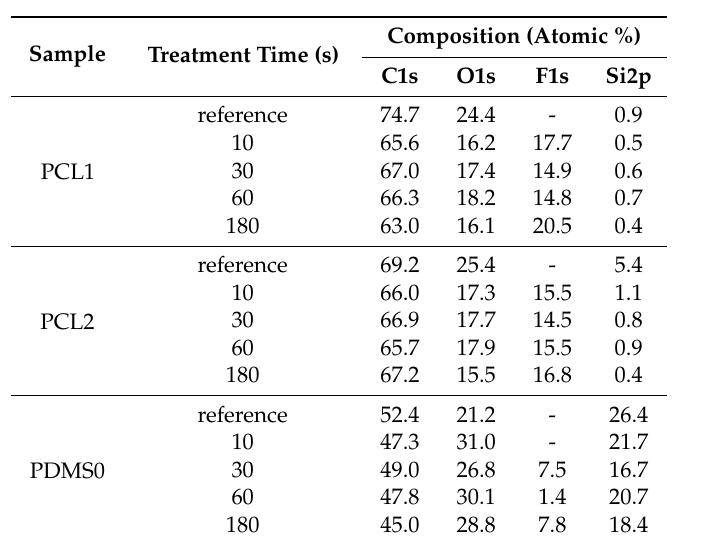
Table 2. Elemental composition after CF 4 treatment (30 W) on PCL and PDMS surfaces. In treatment time column, the “reference” represents 0 s or untreated sample surface.